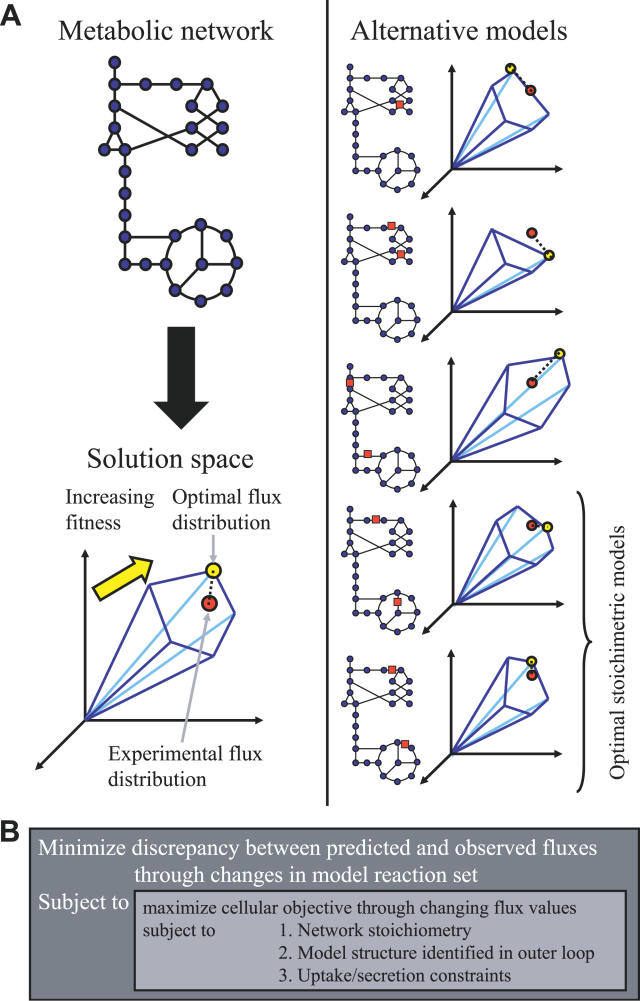
Bilevel Approach to OMNI(A) Schematic illustration of the optimal metabolic network identification approach. Changes in the model reaction set lead to changes in the FBA-predicted optimal flux distribution (yellow) that can be compared to the experimental fluxes (red).(B) Bilevel optimization scheme for optimal metabolic network identification.